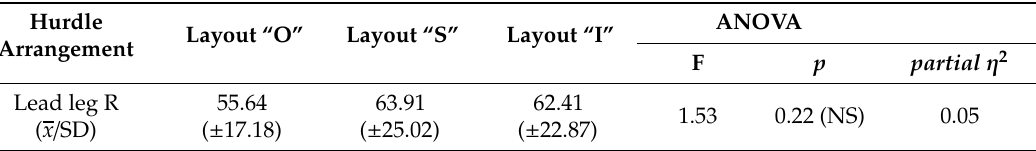
Table 4. Di ff erences in the results of the tests involving hurdle clearance using the right leg for various hurdle arrangements (data in